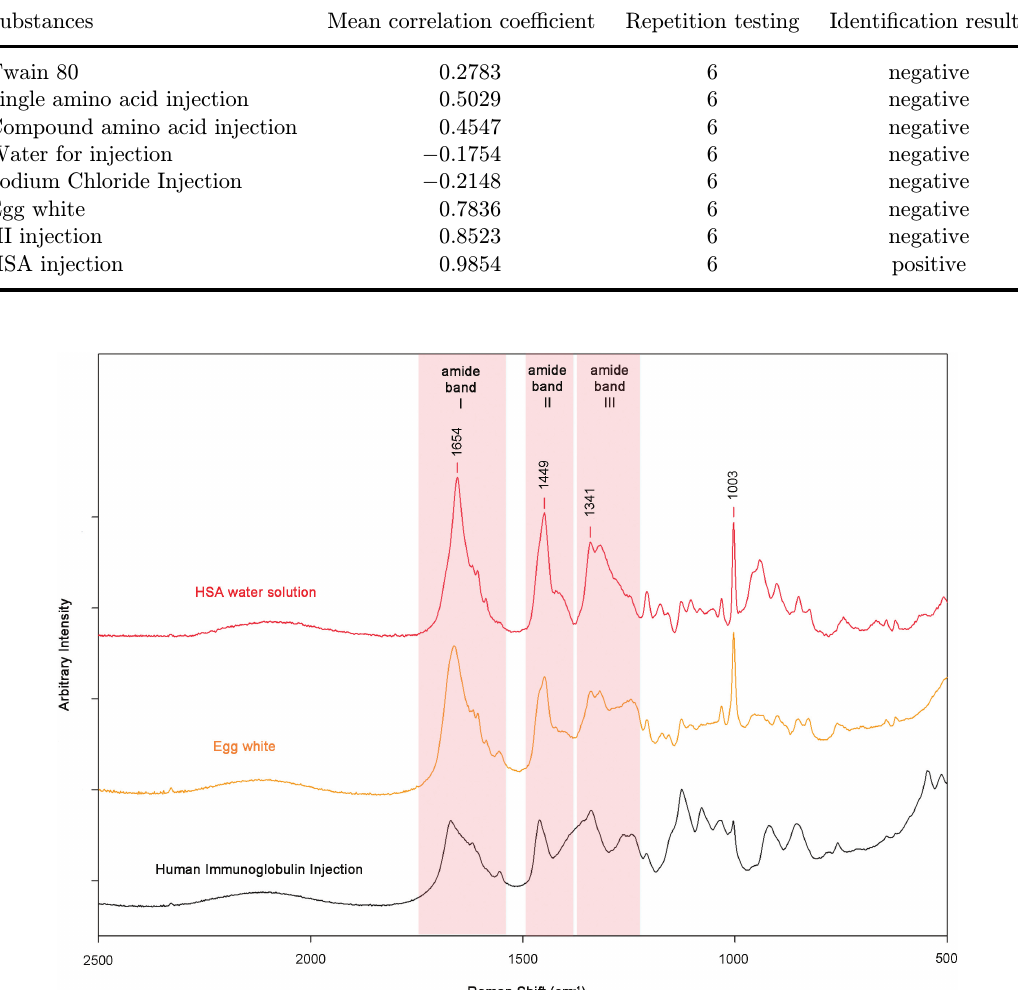
Table 2. Negative challenges and positive testing results on potential counterfeit